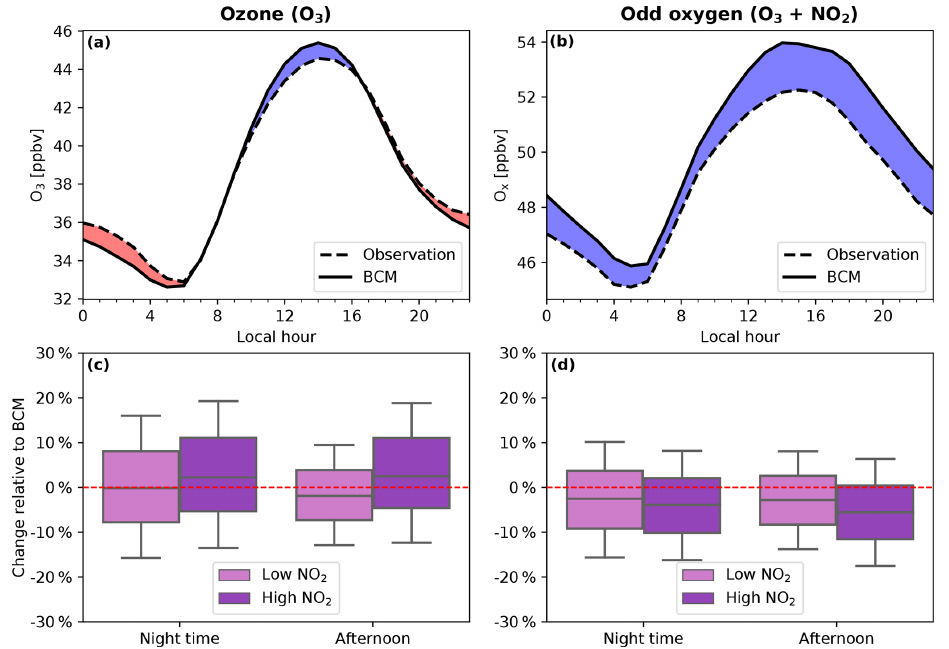
Figure 8. Observed and BCM-modeled diurnal cycle of O 3 (a) and O x (b) averaged across all surface observation sites between 1 Febru- ary 2020 through 30 June 2020 with estimated corresponding changes in surface O 3 (c) and O x (d) relative to the BCM. Bar plots ( c and d ) show observed changes during nighttime (0:00–05:00LT) and the afternoon (12:00–17:00LT) for locations with low ( < 15ppbv) and high ( > 15ppbv) NO 2 concentrations (based on the 2019